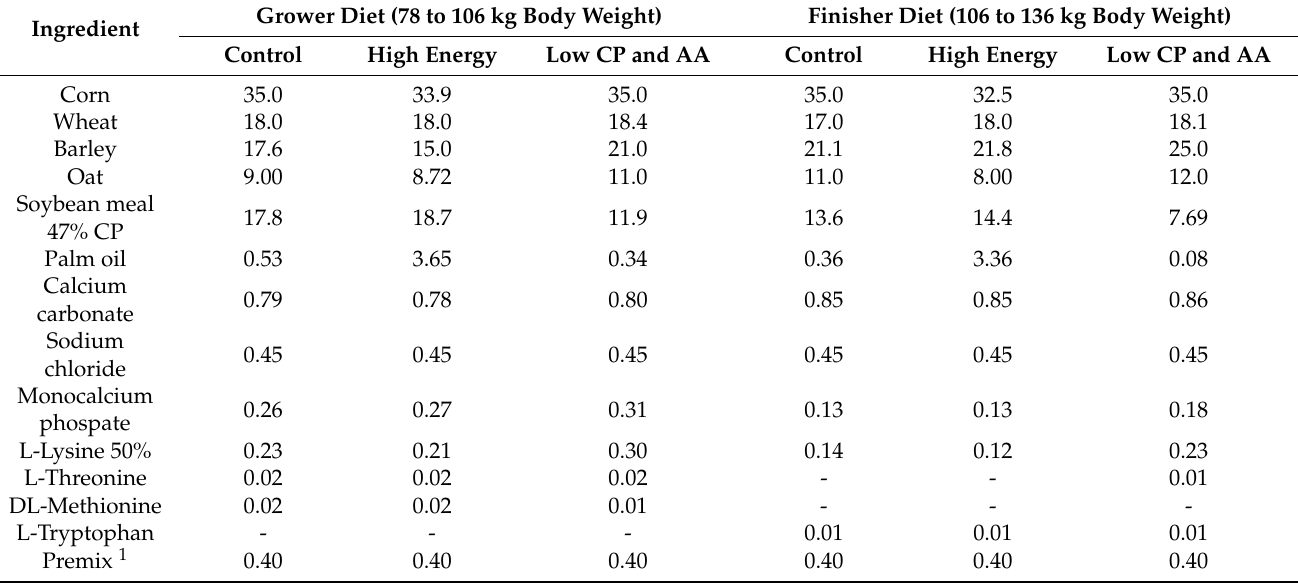
Table 1. Ingredients of the tested diets (%, as-fed basis).